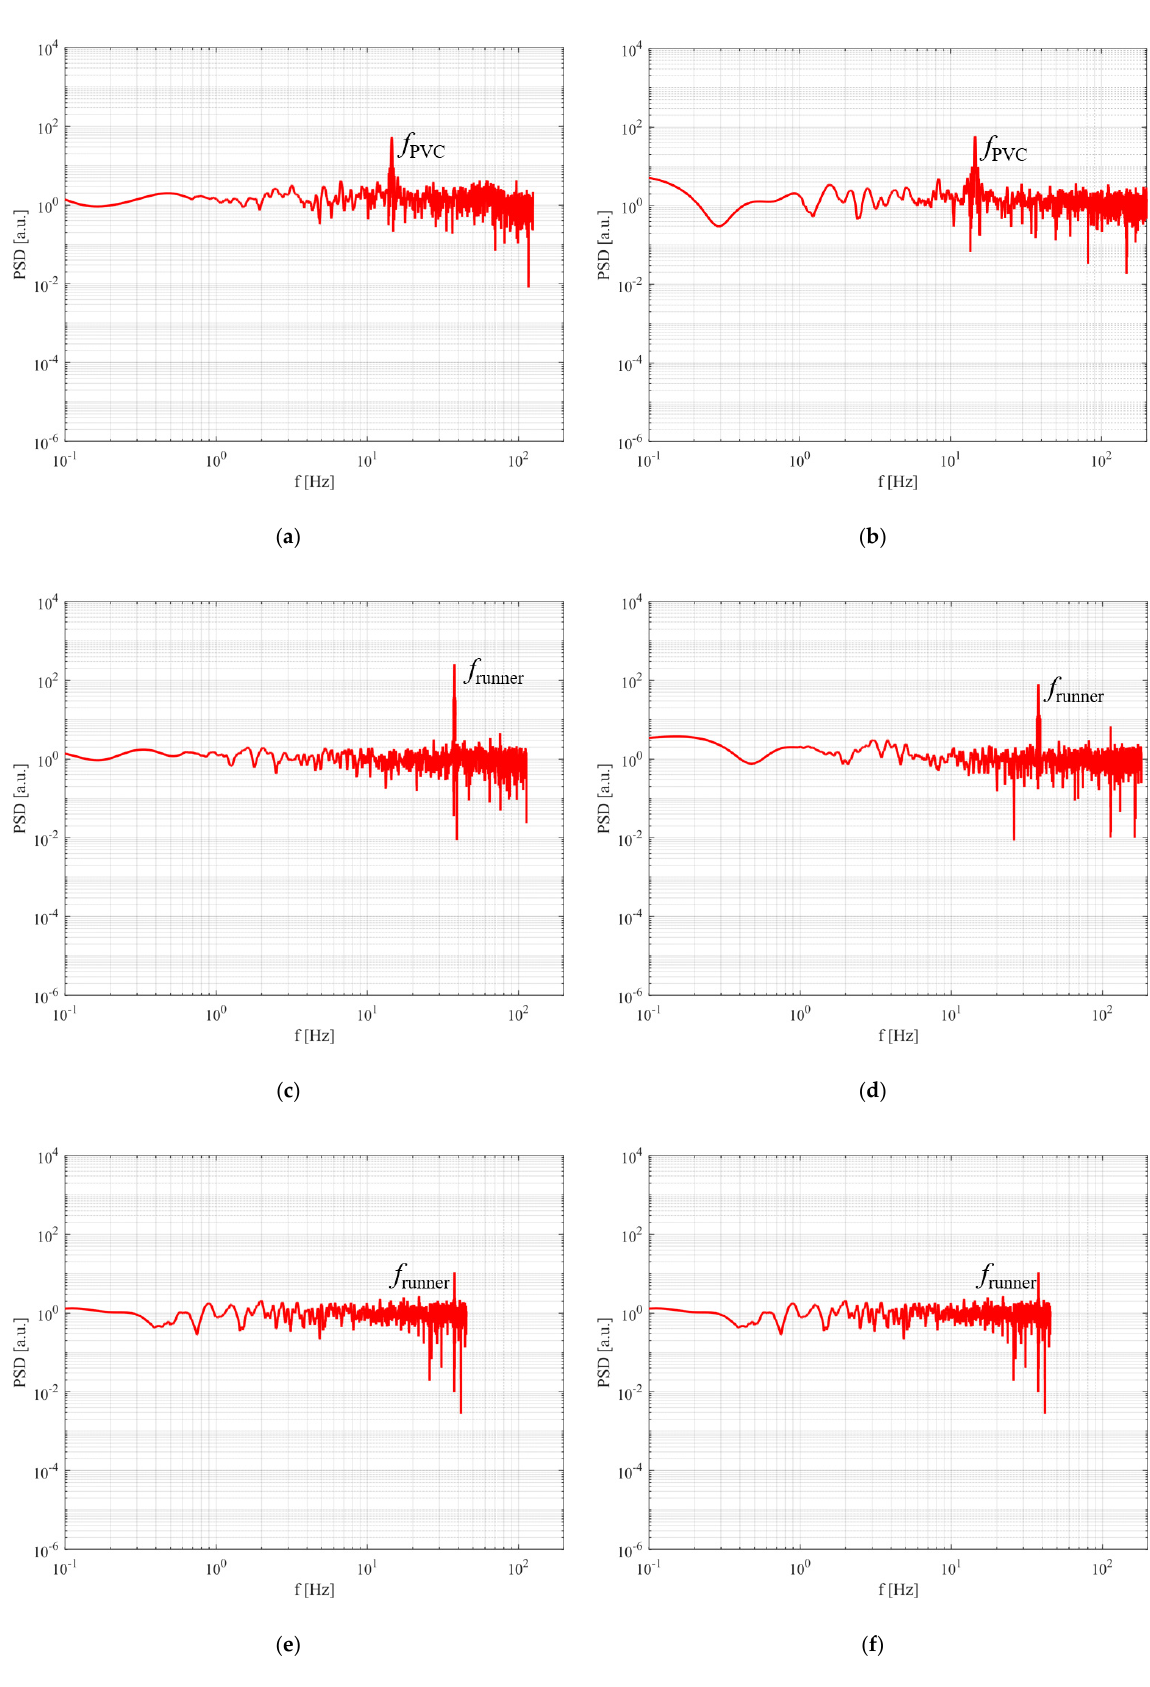
Figure 9. LDA spectra of the velocity pulsations of tangential (left) and axial (right) components at monitor points for: Q = 0.6 Q n ( a , b ); Q = 1.0 Q n ( c , d ), and Q = 1.8 Q n ( e , f